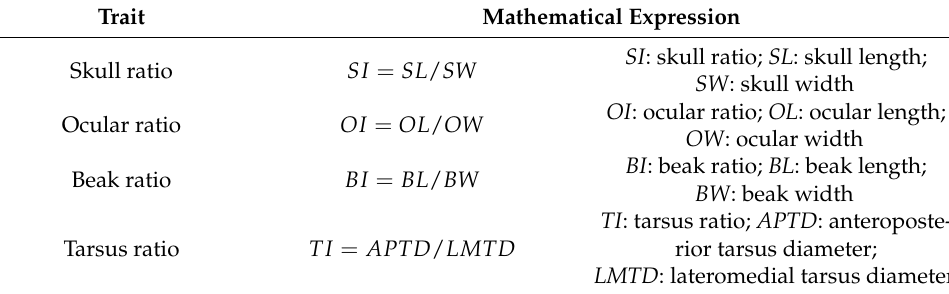
Table 2. Mathematical description of biometric indices.